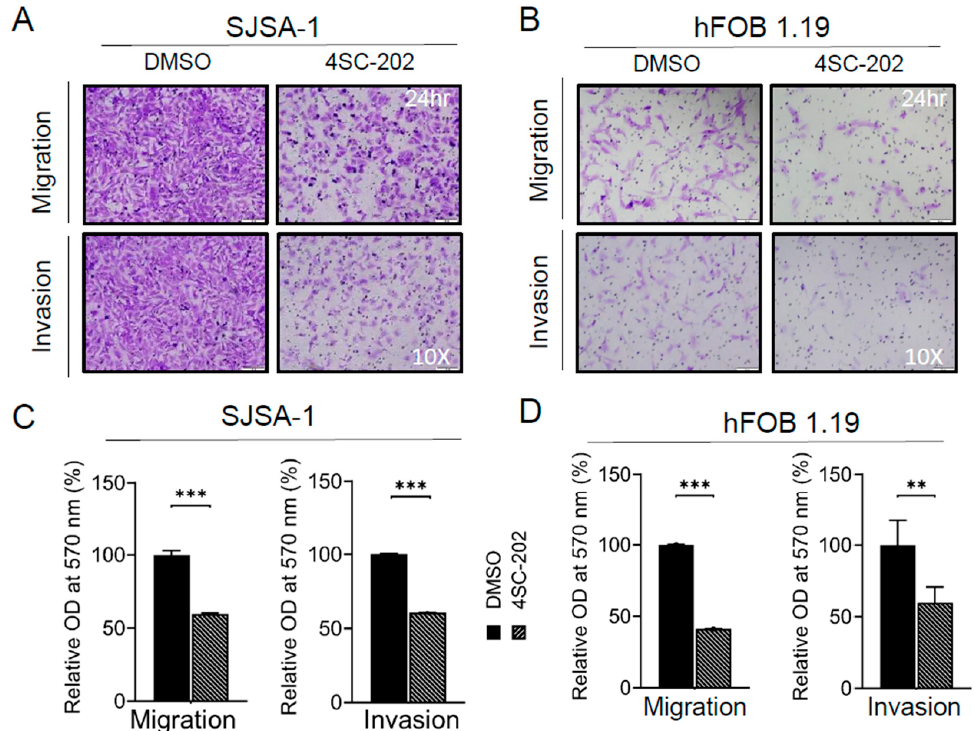
Figure 4. Effect of 4SC-202 on cell migration and invasion. ( A ) Representative images of crystal violet-stained SJSA-1 cell migration (top panel) or invasion (bottom panel) in a trans-well system with or without 4SC-202 treatment under 10× objective magnification. ( B ) Representative images of crystal violet-stained hFOB 1.19 cell migration (top panel) or inva- sion (bottom panel) in a trans-well system treated with or without 4SC-202 under 10x objective magnification. ( C ) Quan- tification of panel A data. ( D ) Quantification of panel B data. ** p < 0.01, *** p < 0.001. Data are presented as mean (SD).